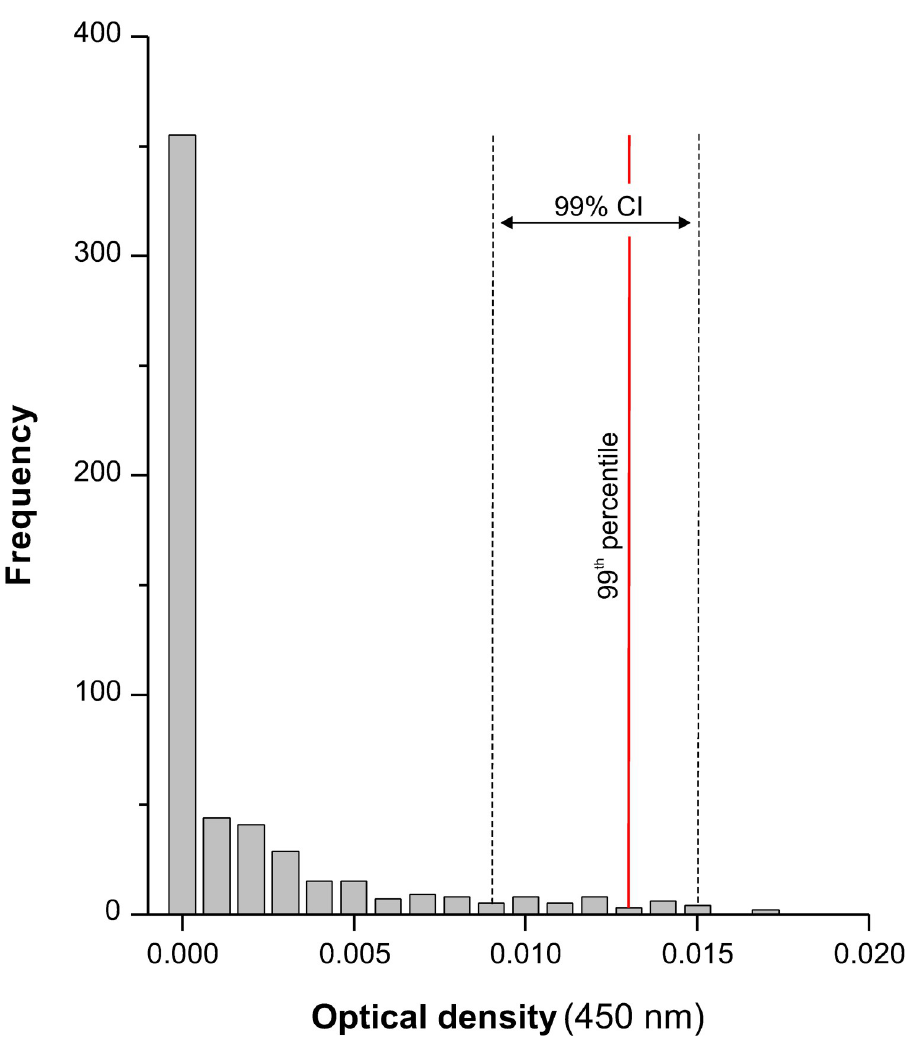
Fig 3. Distribution of OD values obtained with eMM3-COPRO test in the ‘ Fasciola -free’ sheep population (reference population). The solid vertical red line indicates the 99th percentile value (OD = 0.013) and dotted vertical lines indicate the lower (OD = 0.009) and upper (OD = 0.015) limits of the confidence interval for that percentile ( P = 0.01). The reference population included 561 sheep from 15